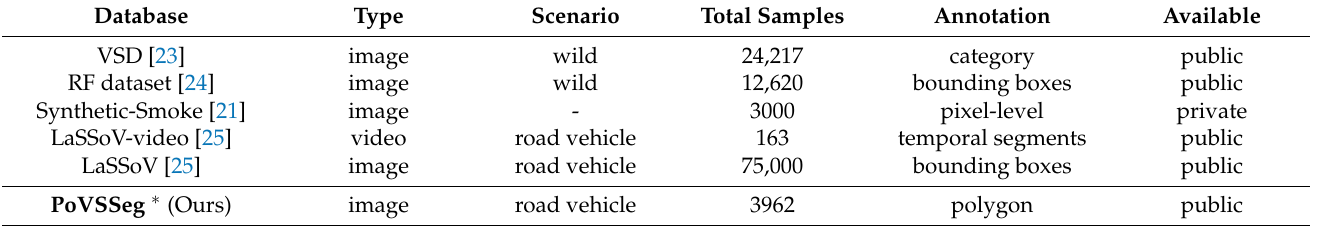
Table 1. The comparison between existing datasets and ours.